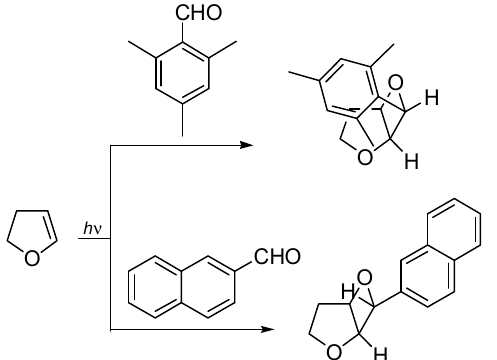
Scheme 9. Different stereochemical behavior in the reactions of